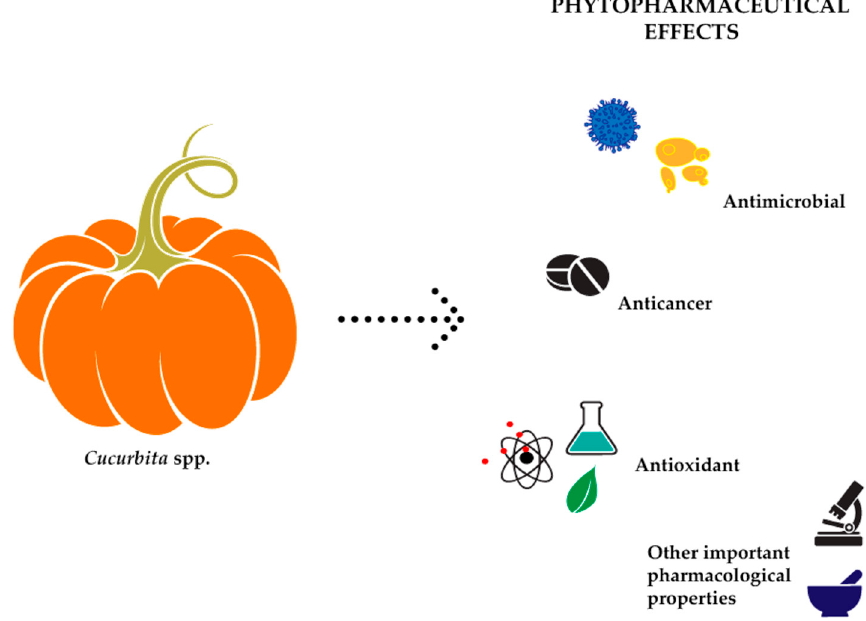
Figure 1. Most pronounced and investigated biological effects of Cucurbita spp.